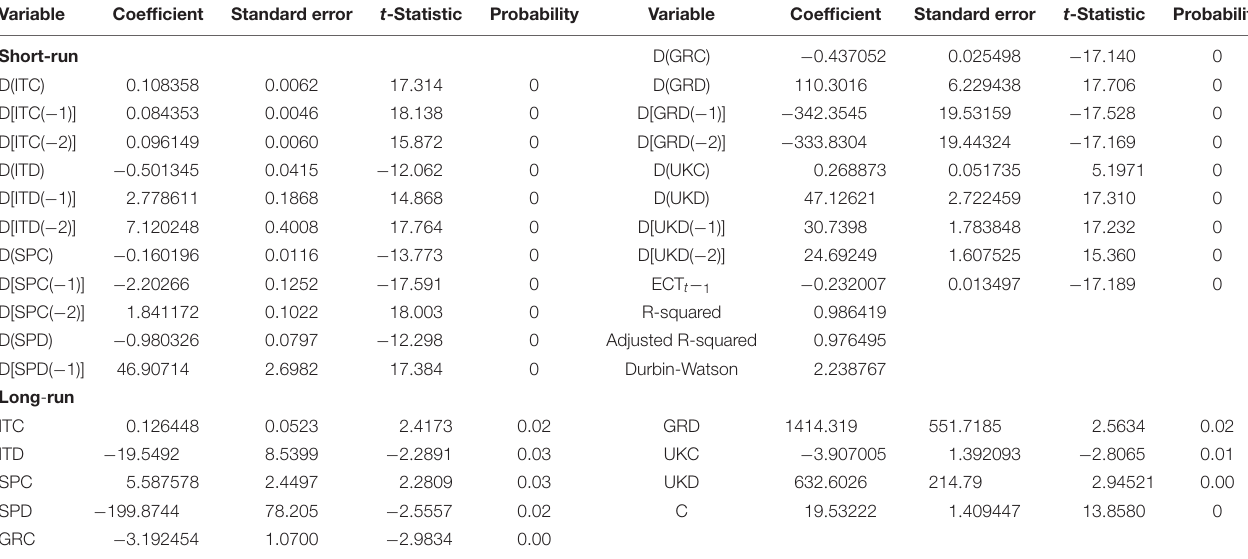
TABLE 4 | Long-run and short-run parameters of model